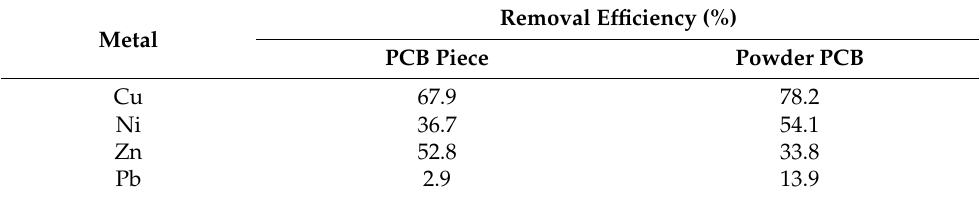
Table 2. Metal removal efficiency values obtained for Cu, Zn, Ni and Pb.